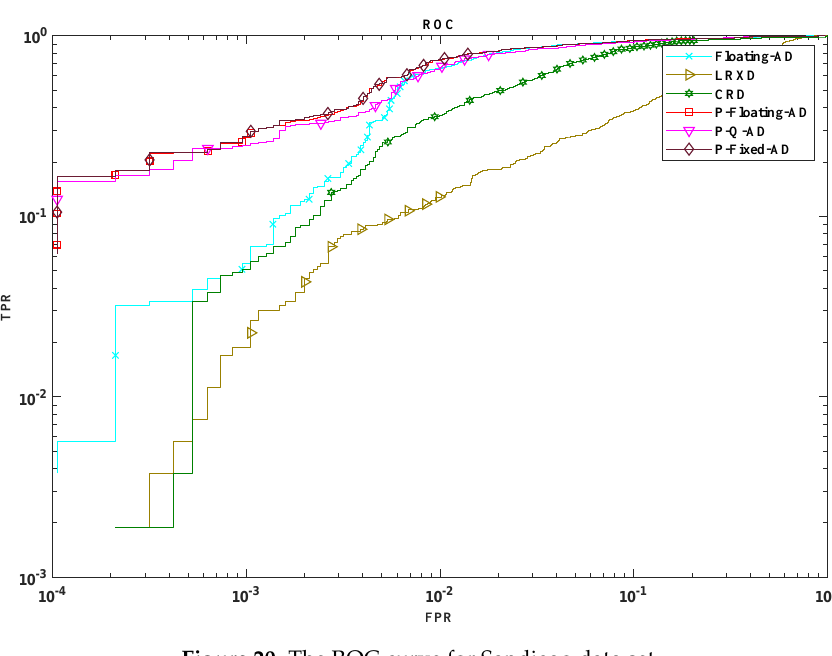
Figure 20. The ROC curve for Sandiego data set. Table 6. The AUC value and the detection time consumption of Sandiego data